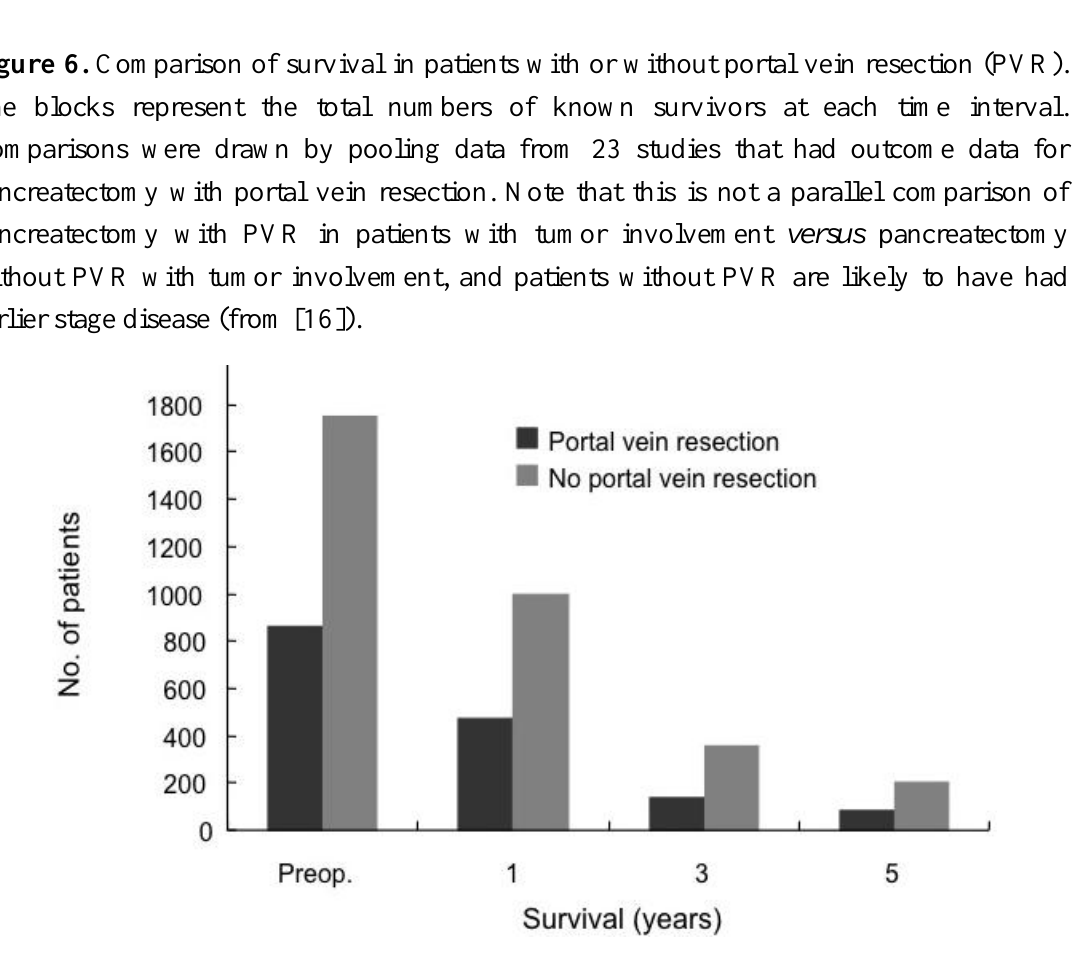
Figure 7. Comparison of cumulative survival rates in patients with no portal vein resection (PV resection(-)), portal vein resection (PV resection(+)), combined resection of portal vein and artery (PVAR; PV resection(+), A resection(+)), and unresectable pancreatic head carcinoma (from